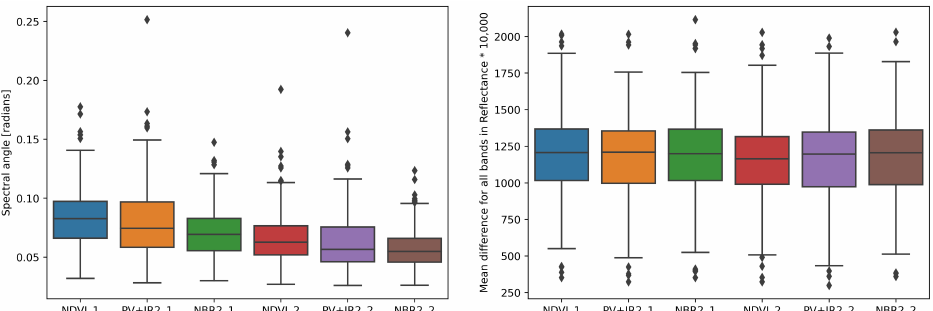
Figure 8. Spectral statistics per SRC version. Index_1 represents SRCs based on t _ min dec , and Index_2 stands for SRC versions calculated with t _ min grass .